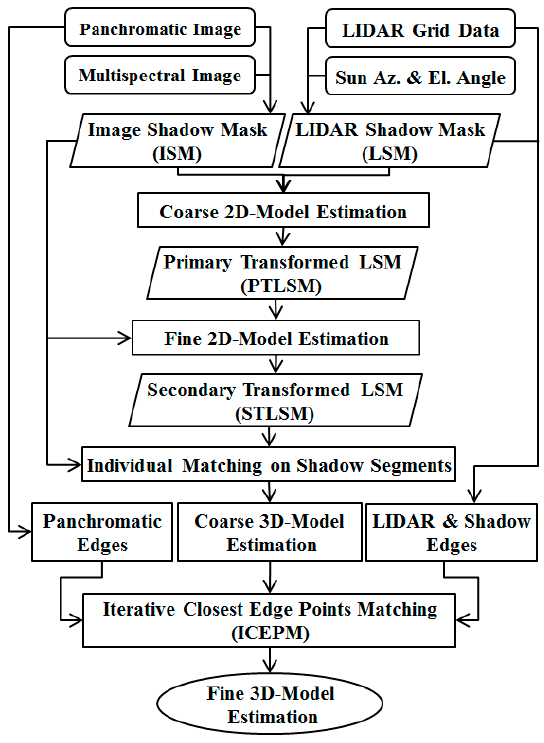
Figure 4. A diagram of the proposed automatic registration of the LiDAR and HRSI.